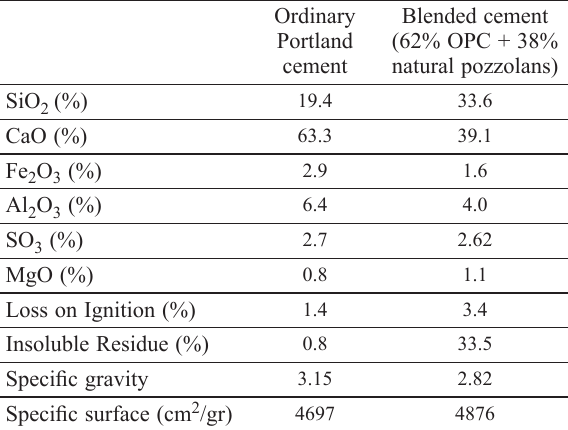
Table 2. Cements characterization